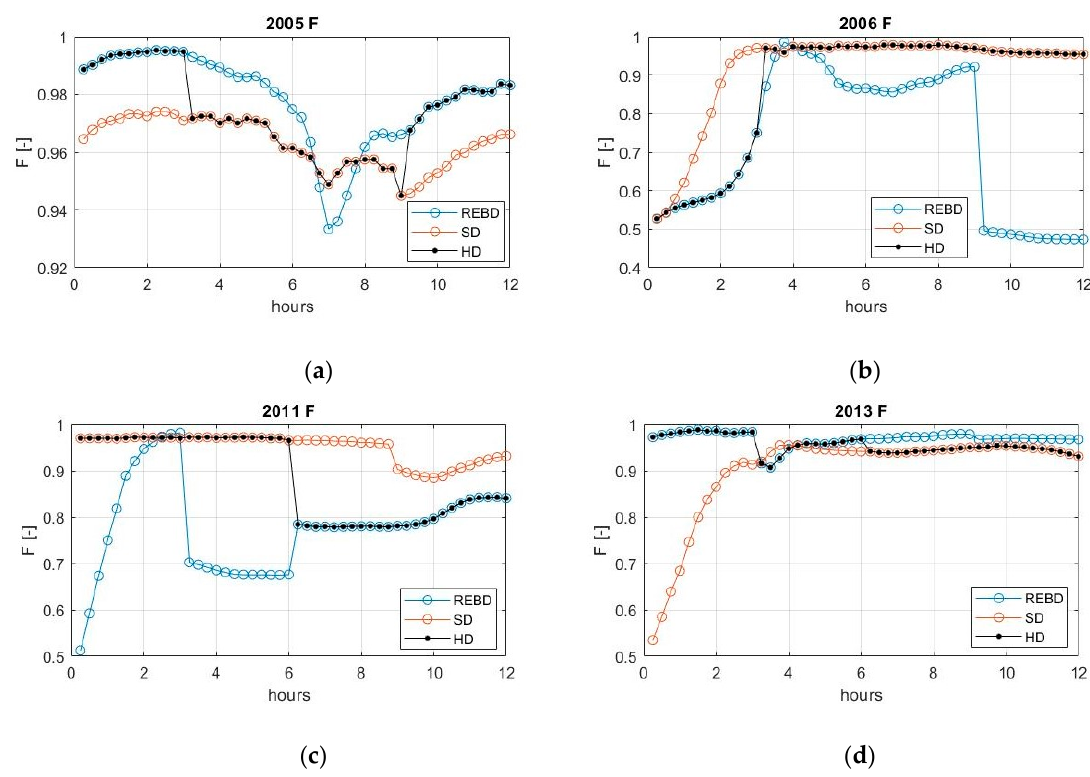
Figure 9. Fit Statistic values every 15 min for the online and offline maps related to the four validation events of 2005 ( a ), 2006 ( b ), 2011 ( c ), and 2013 ( d ) using the REBD, SD, and HD.